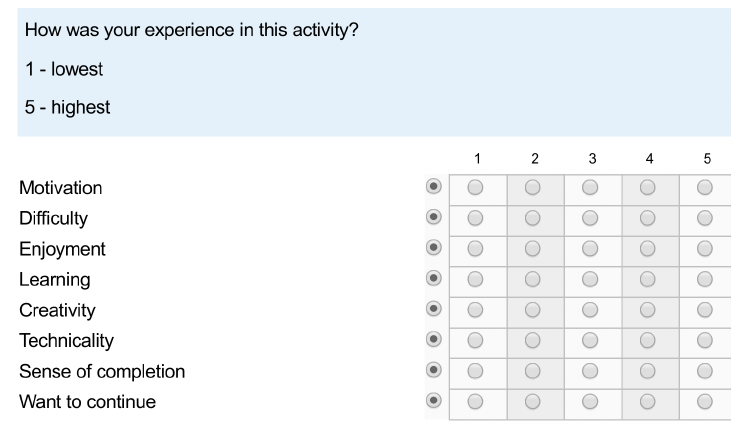
Fig. 3. Screenshot of how the survey looked in our VLE